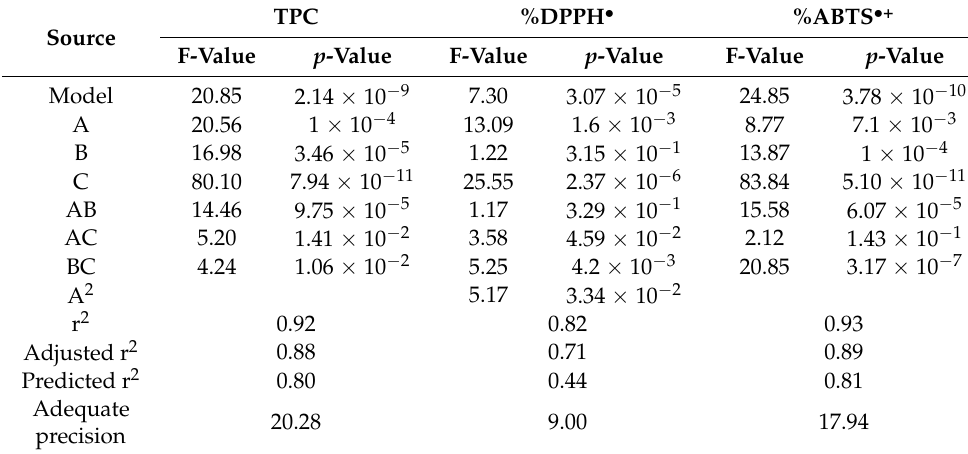
Table 2. Analysis of variance (ANOVA) and fit statistics for total phenolic content (TPC), %DPPH • (1,1-diphenyl-2-picrylhydrazyl) and %ABTS • + (2,2-azino-bis(3-etilbenzotiazolin)-6-sulfonic acid) results. A refers to time (h), B refers to method (without stirring, ultrasound, or stirring), and C refers to solvent (methanol, water, or ethanol).